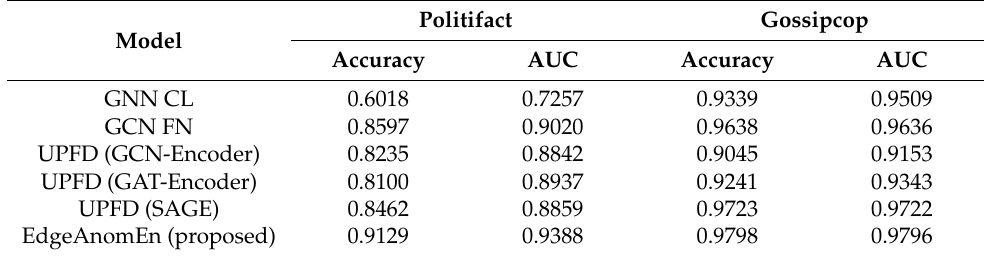
Table 3. Base method vs. EdgeAnomEn comparison: accuracy and AUC for edge anomaly detection on PolitiFact and GossipCop